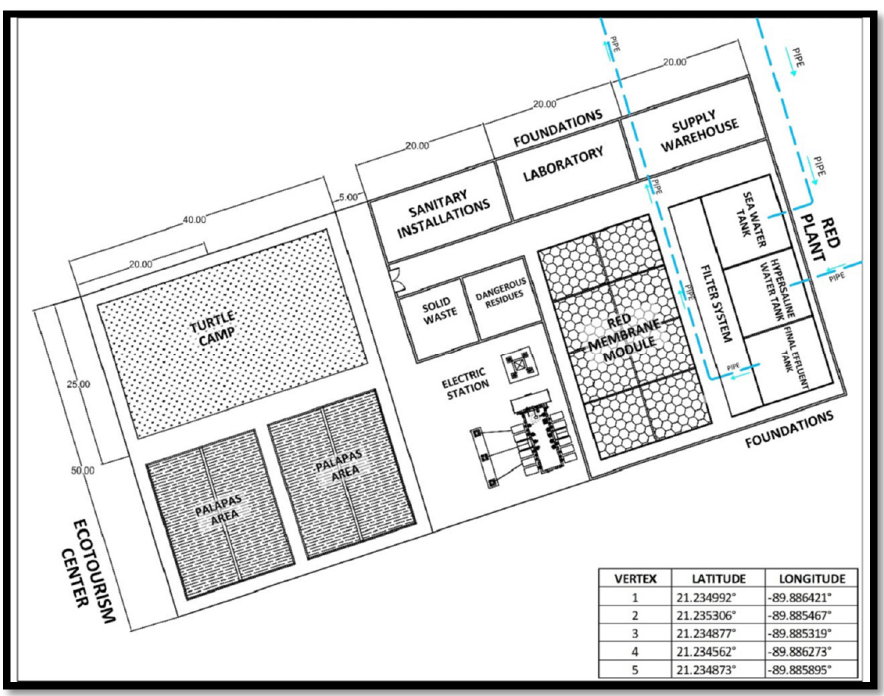
Figure 4. Potential location of the RED pilot power plant; the dotted lines indicate the pipelines.